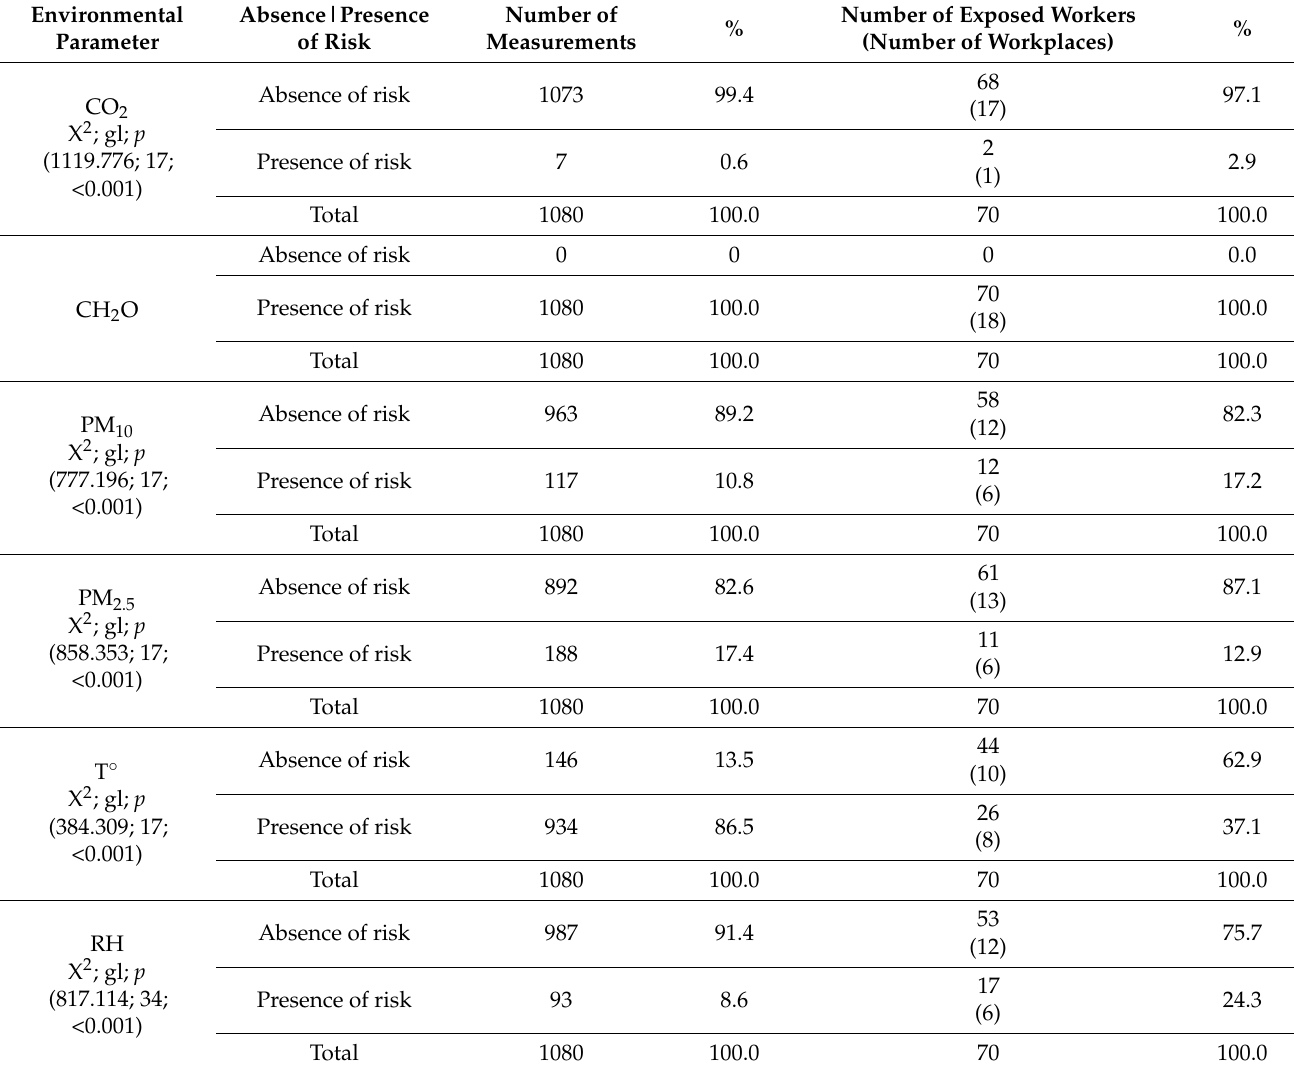
Table 3. Presentation of the measurements in which workers were faced with concentrations that exceeded the protection threshold in the